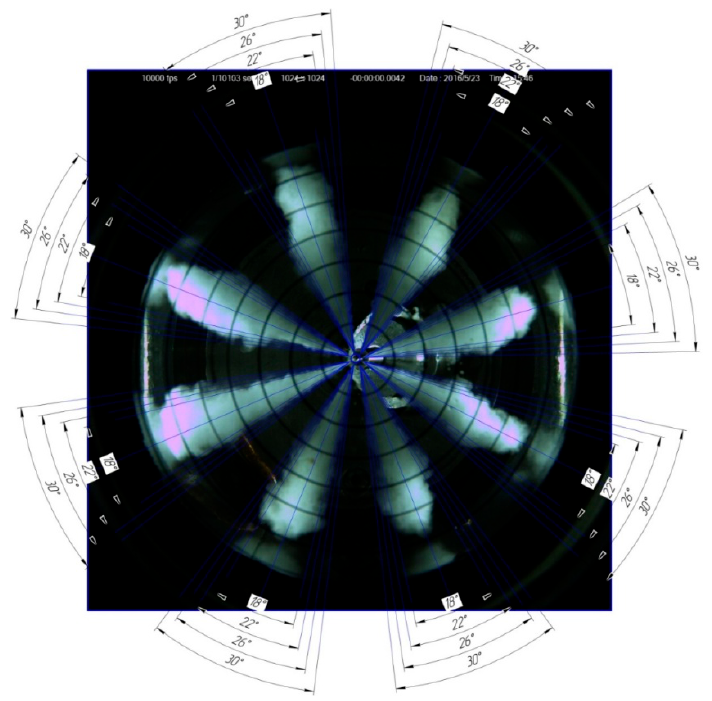
Figure 8. Determination of the fuel spray cone angles by the marked angles.